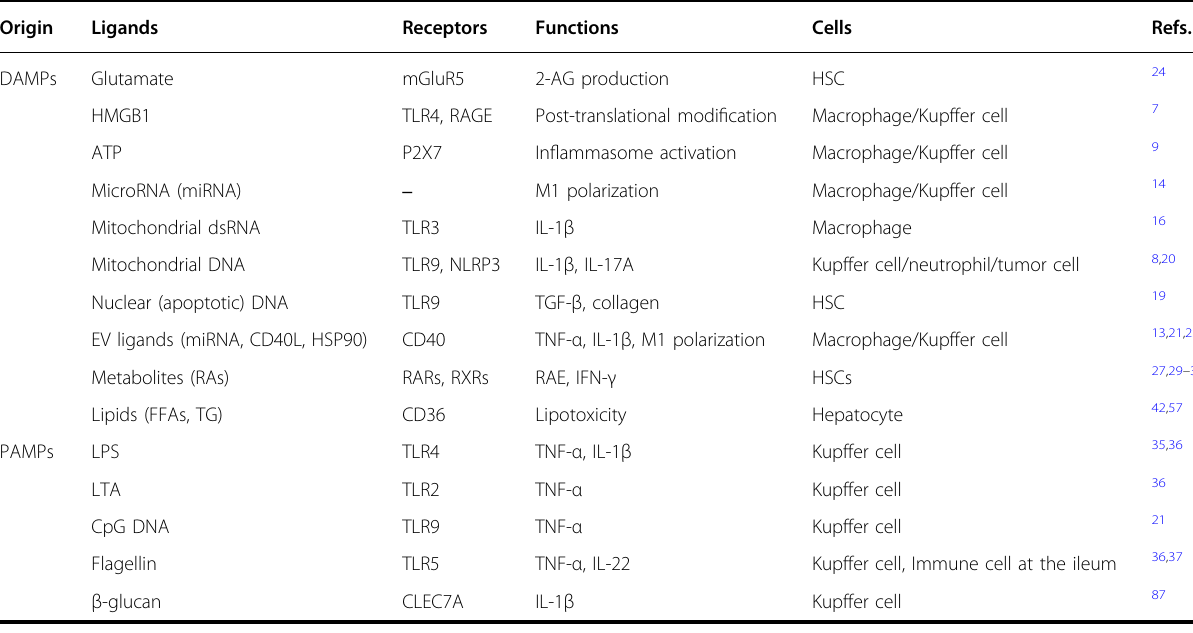
Table 1 DAMPs and PAMPs in